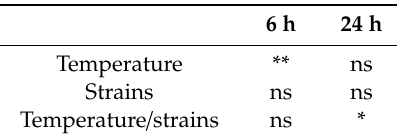
Table 1. Two-way analysis of variance performed on the acidification scores after 6 and 24 h—ns, not significant; * p < 0.05; ** p < 0.01.